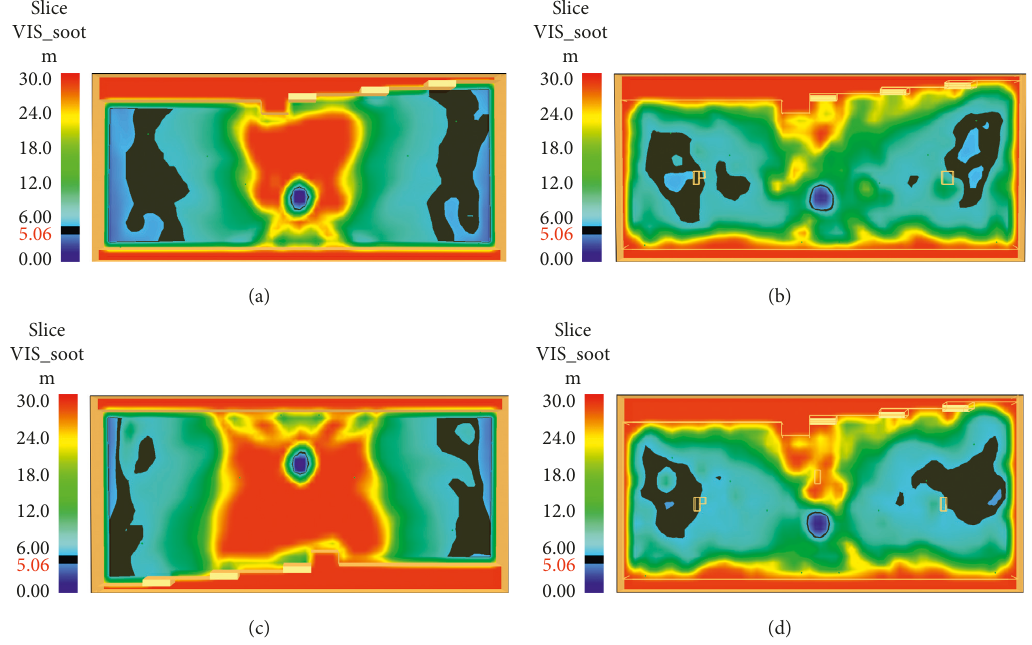
Figure 4: Critical time of fire hazard for scenario C. (a) C00, (b) C01, (c) C10, and (d)